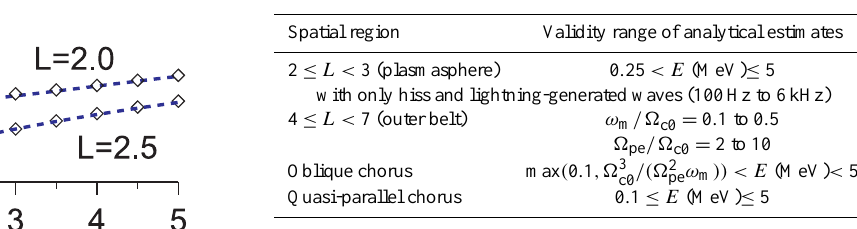
Table 2. Parameter domains where analytical lifetime estimates are a good approximation for the full numerical